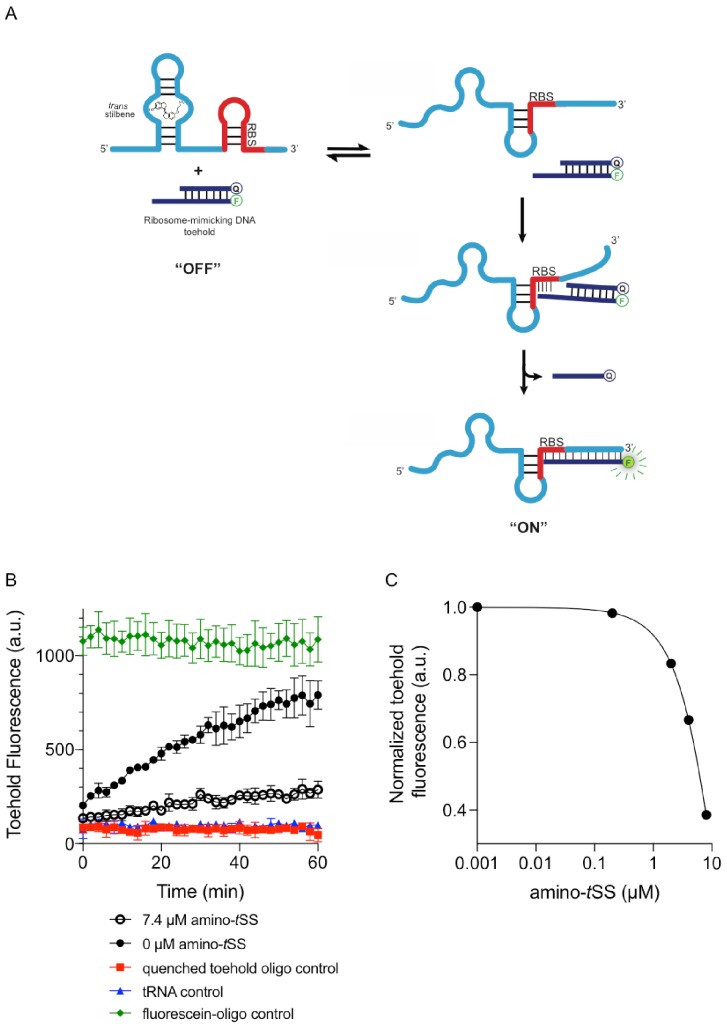
Binding PAGE-purified Were-1 RNA to a ribosome-mimic.(a) Schematic of strand displacement, where a DNA duplex containing a toehold complementary to the Shine-Dalgarno sequence of Were-1 is displaced when no amino-tSS is present, producing a fluorescence. (b) The presence of amino-tSS prevents the quencher strand release, suppressing toehold fluorescence (± SD) over time. Control reactions were performed using the unquenched fluorophore oligo (green) and the quenched toehold oligo (red) for fully quenched fluorescence to provide a window for maximum fluorescence, and a tRNA (blue) lacking the Shine-Dalgarno sequence as a negative control. (c) Dose-response curve of PAGE-purified Were-1 RNA in the presence of increasing concentrations of amino-tSS and analyzed by the toehold-fluorescence assay. Half maximum fluorescence is observed at 6.3 µM amino-tSS.Figure 2—figure supplement 1—source data 1.Time course of toehold binding by Were-1.